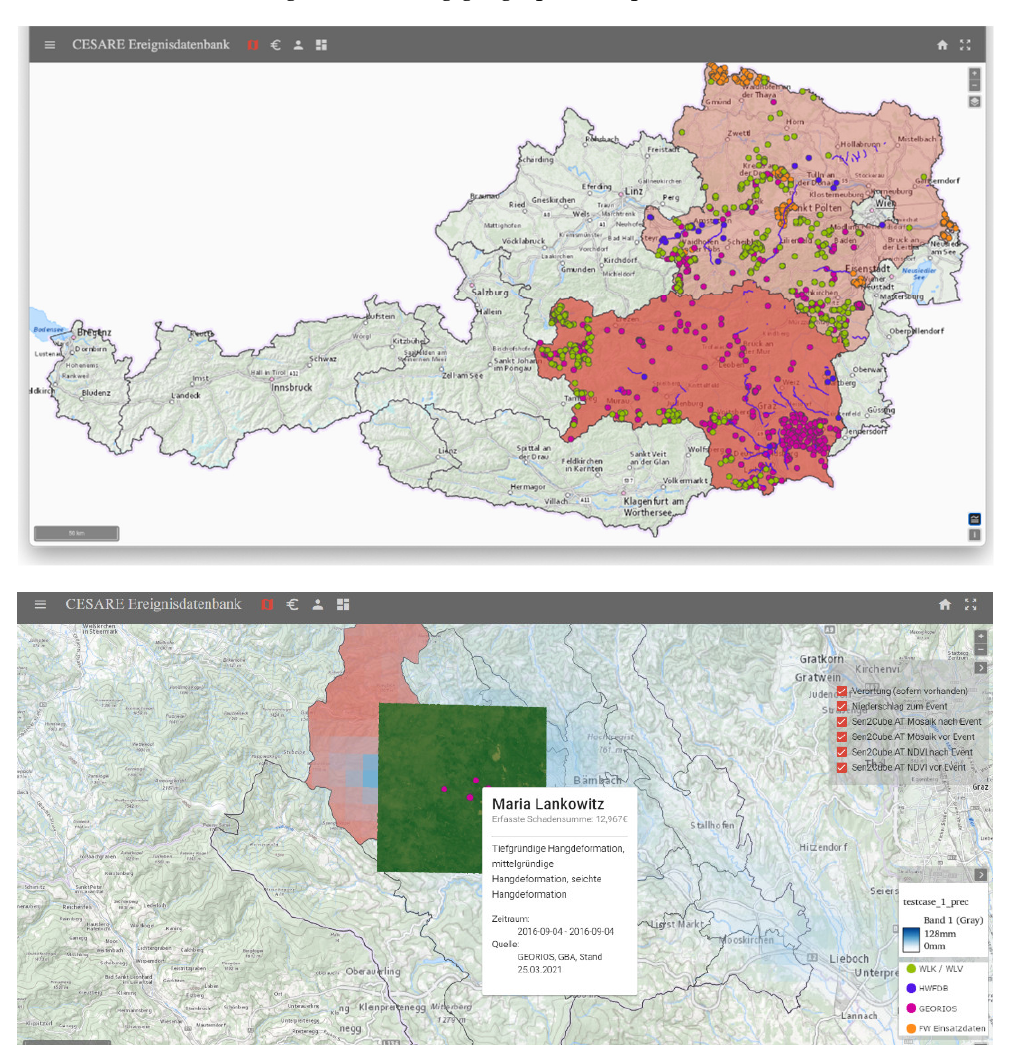
Figure 6. Snapshot of the CESARE map service. The upper map shows the landing page including an overview of all integrated data, the lower map displays a zoom-in to a selected event with additional data (weather and EO data) for data analysis. The demonstrator is provided in German for the Austrian users.